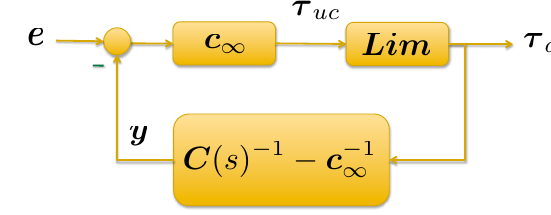
Figure 3: Anti-windup implementation of a minimum- phase bi-proper